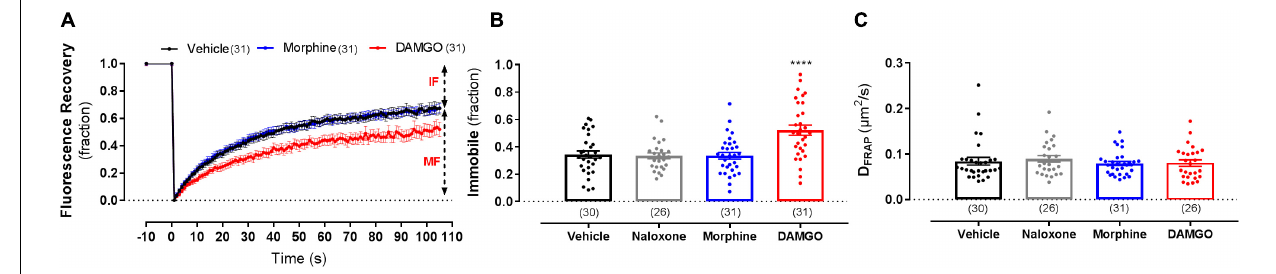
FIGURE 3 | Fluorescence recovery after photobleaching measurements on the lower membrane of HEK293 SNAP-MOP cells following ligand stimulation. (A) Fluorescence recovery curves of HEK293 SNAP-MOP cells during FRAP experiments under control conditions and following stimulation with 30 µ M morphine or 10 µ M DAMGO for 20 min at 37 ◦ C ( n = 26–31 from 6 independent experiments). MF, mobile fraction and IF, immobile fraction. (B) Immobile fraction and (C) diffusion coefficient of SNAP-MOP as determined by FRAP (D FRAP ) analysis following stimulation with 30 µ M naloxone, 30 µ M morphine or 10 µ M DAMGO ( n = 26–31 from 6 independent experiments; one-way ANOVA, F (df1,df2): F (3,114) = 10.48, P < 0.0001). Each data point of the scatter plots represents an individual cell measurement (number of cells in parenthesis) and column plots represent mean ± SEM of the indicated number of cells. ∗ denotes significance vs. vehicle treatment in one-way ANOVA with Sidak’s multiple comparisons test ( ∗∗∗∗ p < 0.0001).